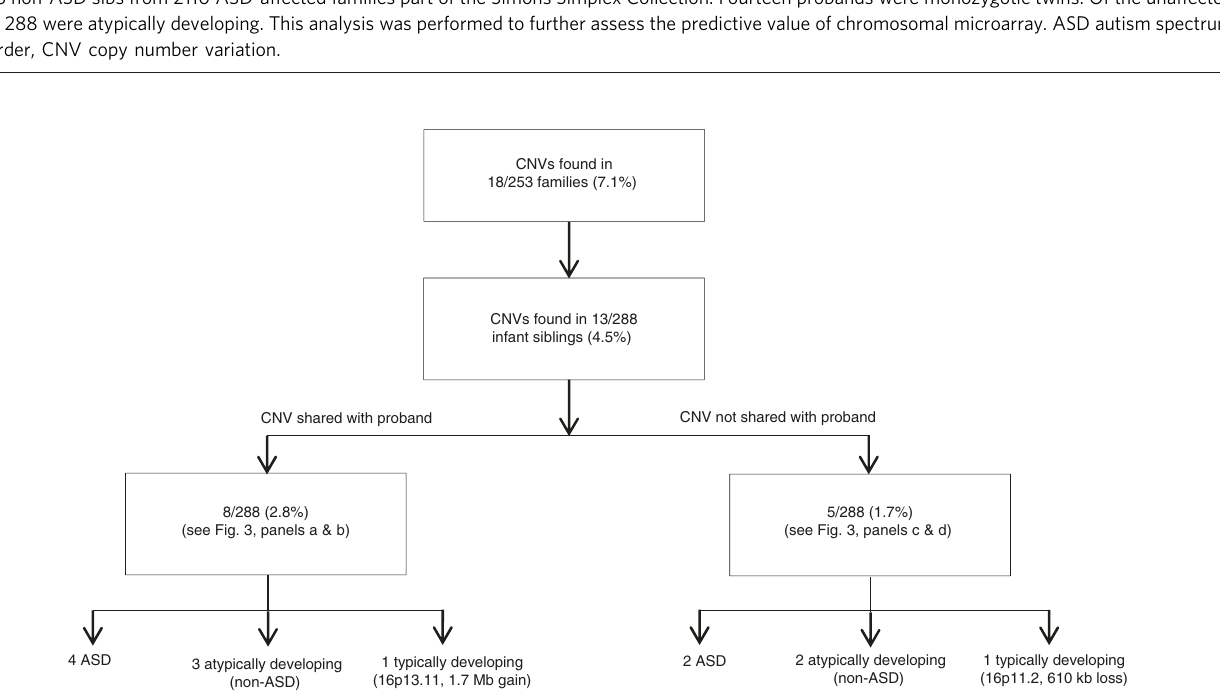
Fig. 2 ASD-relevant CNVs among infant siblings ( n = 288). Summary of ASD-relevant genetic fi ndings in the infant sibling cohort, strati fi ed by family segregation and infant sibling phenotype. ASD autism spectrum disorder, CNV copy number